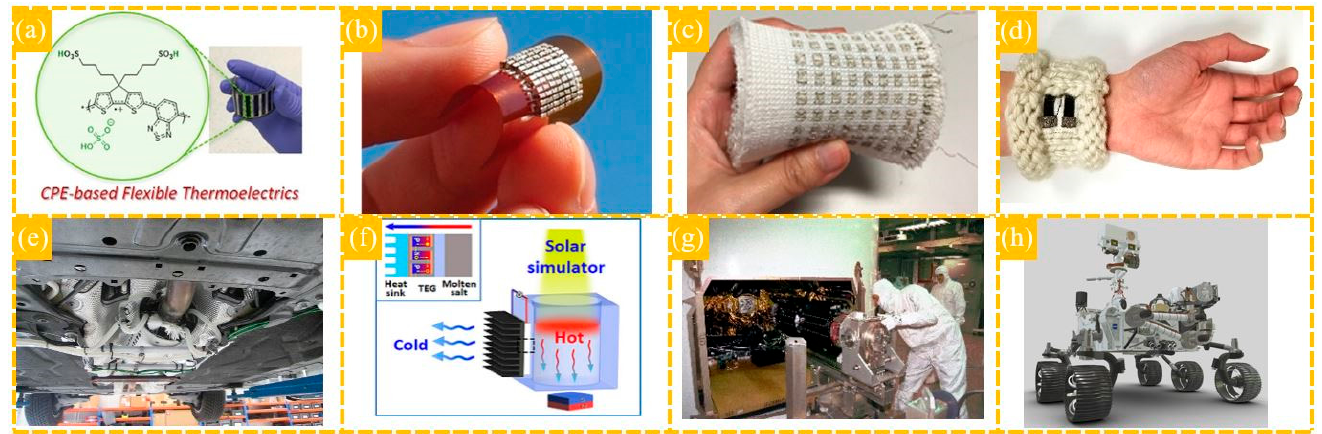
Figure 6. Recent decades: 21st century: ( a ) self-doped conjugated polyelectrolytes (CPEs) has been evaluated as a promising class of conductive organic for organic thermoelectrics (adapted from [16] with permission), ( b ) photograph of a prototype for a compact and flexible TEG (CF-TEG) using ultra-fine chip mounting technique. It is made of 84 p-n pairs fabricated on a 10 × 10 mm 2 flexible substrate. It produced a maximum output voltage and power density of 2.4 V and 185 mWcm − 2 , respectively, at ∆ T = 150 K (adapted from [17] with permission), ( c ) photograph of a flexible TEG prototype. It is fabricated by a locknit spacer fabric as the substrate and yarns are coated with waterborne polyurethane/carbon nanotube thermoelectric composites as legs (thermocouples), (adapted from [18] with permission), ( d ) body-heat harvester made with cotton. A vapor-deposited strip of cotton fabric-coated with p-doped poly(3,4-ethylenedioxythiophene) [19]. Photo source: IEEE spectrum [20], ( e ) an automotive thermoelectric generator (ATEG) is built and tested experimentally on the exhaust system of the engine cell (adapted from [21] with permission), ( f ) schematic illustration of the solar–thermal–electric conversion system (STECS) constructed by a movable charging solar–thermal storage and TE conversion subsystems. The magnet installed at the bottom of the solar–thermal storage subsystem is to make movable charging of the molten salts inside the container (adapted from [22] with permission), ( g ) installation of thermoelectric generator systems on the Cassini spacecraft, photo credit: NASA [23], and ( h ) NASA’s Mars 2020 rover is powered based on thermoelectric power generation [24].